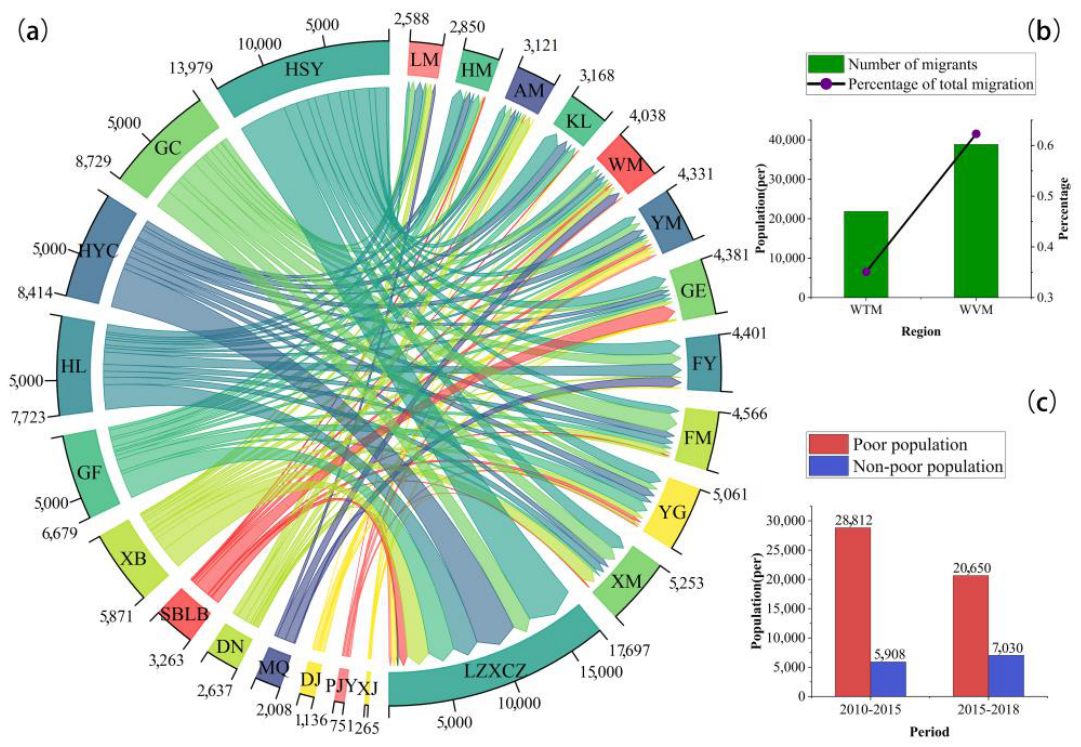
Figure 4. ( a ) The flow of ecological migrants out of and into the county; ( b ) the proportion of ecological migrants in the WTM and WVM areas; ( c ) the proportion of poor migrants in different periods. The abbreviations in the map are as follows: LZXCZ, Luzhouxiaochengzhen; XM, Xinming; YG, Yangguang; FM, Fuming; FY, Fuyuan; GE, Ganen; YM, Yuanmeng; WM, Weiming; KL, Kangle; AM, Aiming; HM, Huiming; LM, Leming.